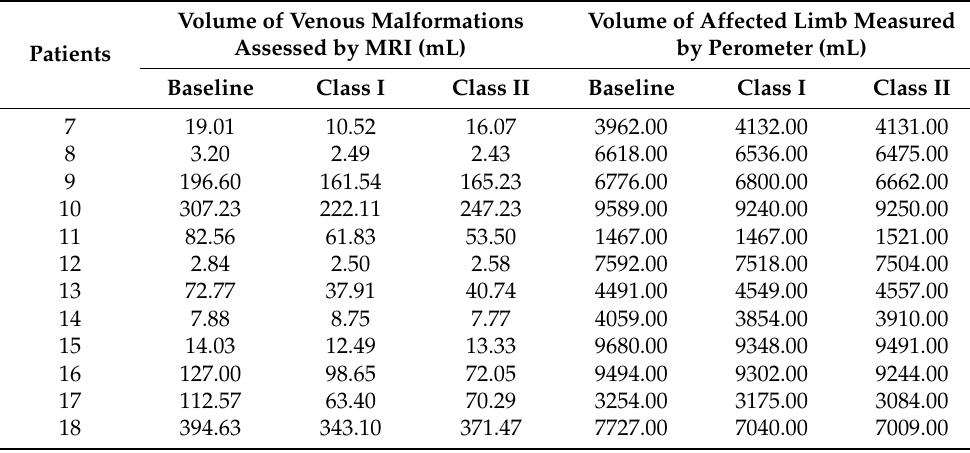
Table 5. Mean and range of wearing time (hours per day) of the medical device.